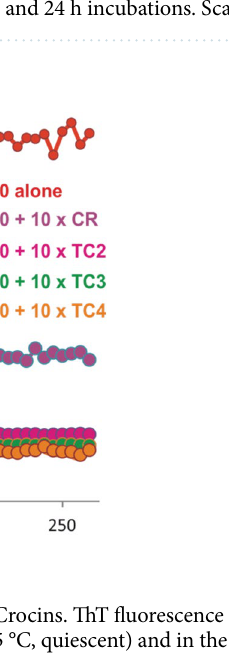
Figure 5. A time-series of Aβ1-40 peptide sample without/with TC4 analyzed by negative stain TEM. Samples were prepared at start of the experiment and after 1, 4 and 24 h incubations. Scale bars 100 nm.